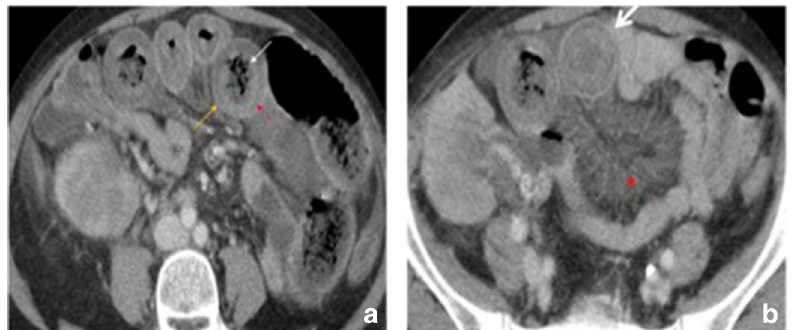
Fig. 10 Bowel wall thickness and enhancement. a Contrast-enhanced axialCTimagesshowa target sign(larger whitearrow)inthe small bowel wall due to mesenteric venous occlusion. b The vascular engorgement (*) and oedema of the bowel wall in turn lead to leakage of extravascular fluid into the bowel wall and mesentery. The resultant oedematous bowel